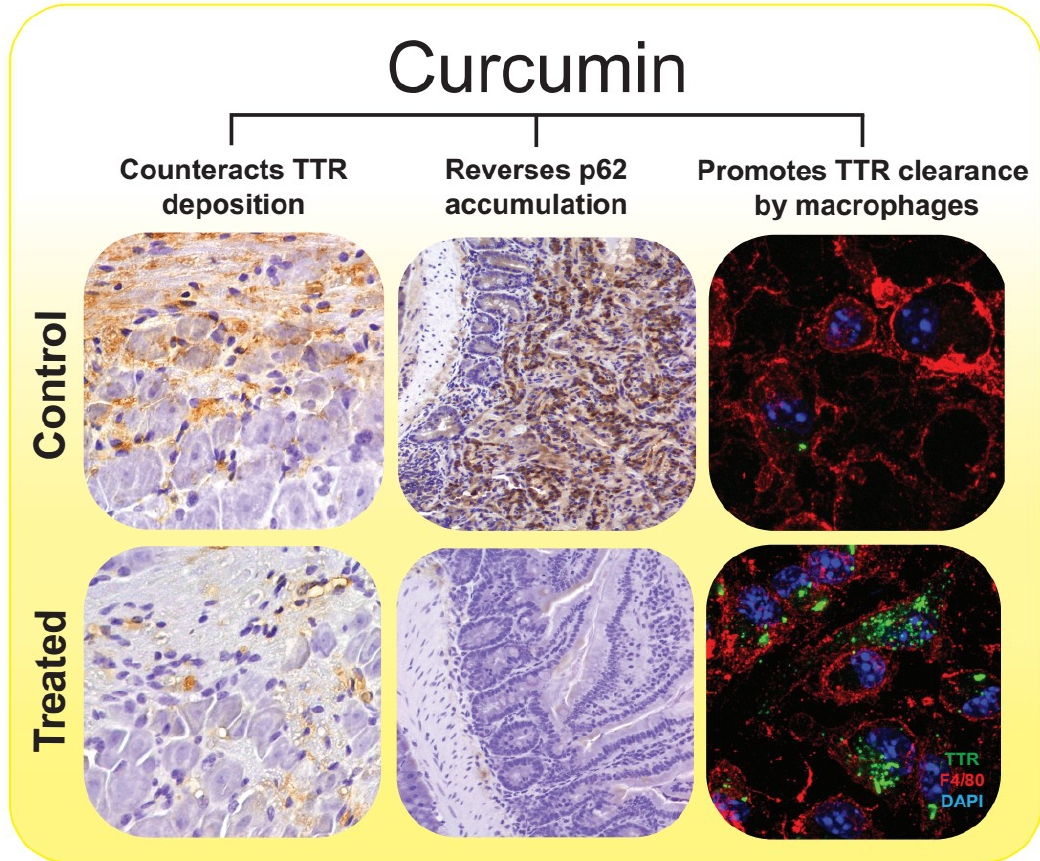
Figure 2. The pleiotropic effects of curcumin on the molecular pathways associated with ATTR amyloidosis. Curcumin exerts neuroprotective effects on ATTR amyloidosis by modulating TTR abnormal aggregation and counteracting TTR tissue deposition (left panels, 20× magnification) immunohistochemistry (IHC) analysis of TTR in dorsal root ganglia (DRG) from mice expressing human TTR V30M (hTTRV30M mice) treated with curcumin and age-matched controls [70]), re-establishing the autophagic flux by reversing p62 accumulation (center panels, 20× magnification), IHC analysis of p62, in duodenum samples from hTTRV30M mice treated with curcumin and age-matched controls [87]) and improving the phagocytic uptake and degradation of extracellular TTR aggregates by macrophages (right panels, 63× magnification), double immunofluorescence labeling for TTR, in green, and F4/80, in red, of primary macrophages from hTTRV30M mice that were pre-incubated in presence of curcumin or its absence (control), before addition of TTR aggregates to cell culture medium [70]). Nevertheless, other well-known neuroprotective properties of curcumin, such as its anti-inflammatory, anti-apoptotic, and anti-oxidative activities [78,94], might potentiate its in vivo effects.